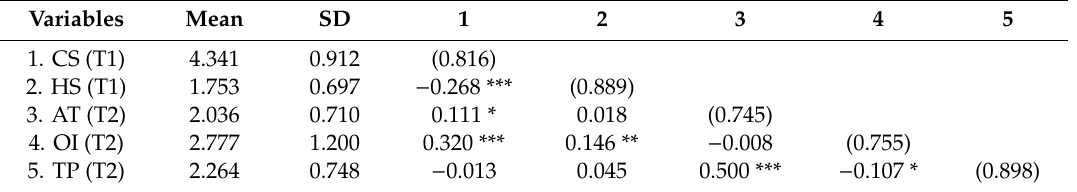
Table 2. Descriptive statistics and intercorrelations between measures.